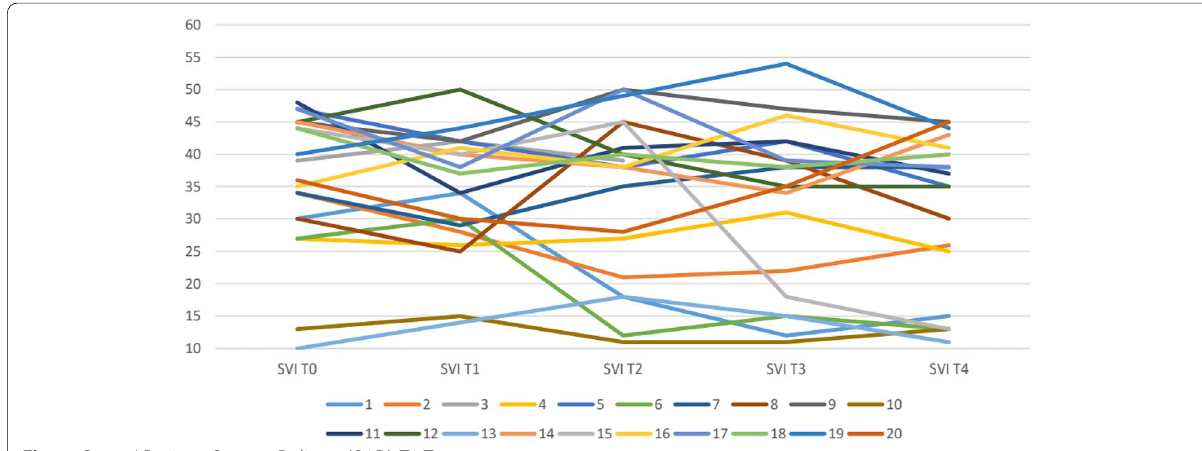
Fig. 4 Group I Patients Oxygen Delivery (O2D),